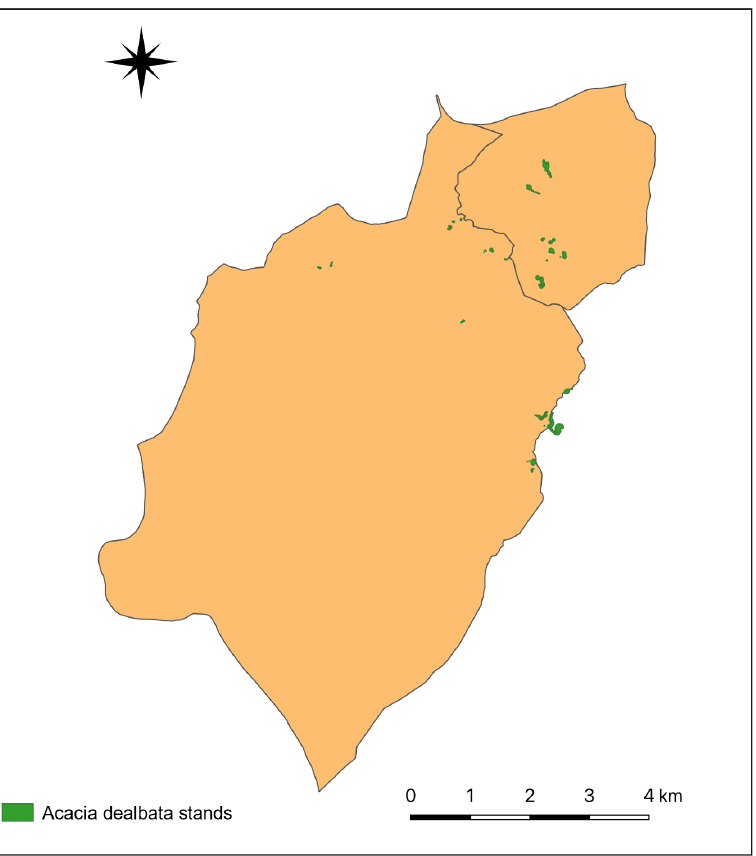
Figure 5. Distribution of A. dealbata settlements in the territory of the União de Freguesias de Cabeça e Vide. Table 5. Area of settlements of A. dealbata existing in the territory of the Uni ã o de Freguesias de Cabeça e